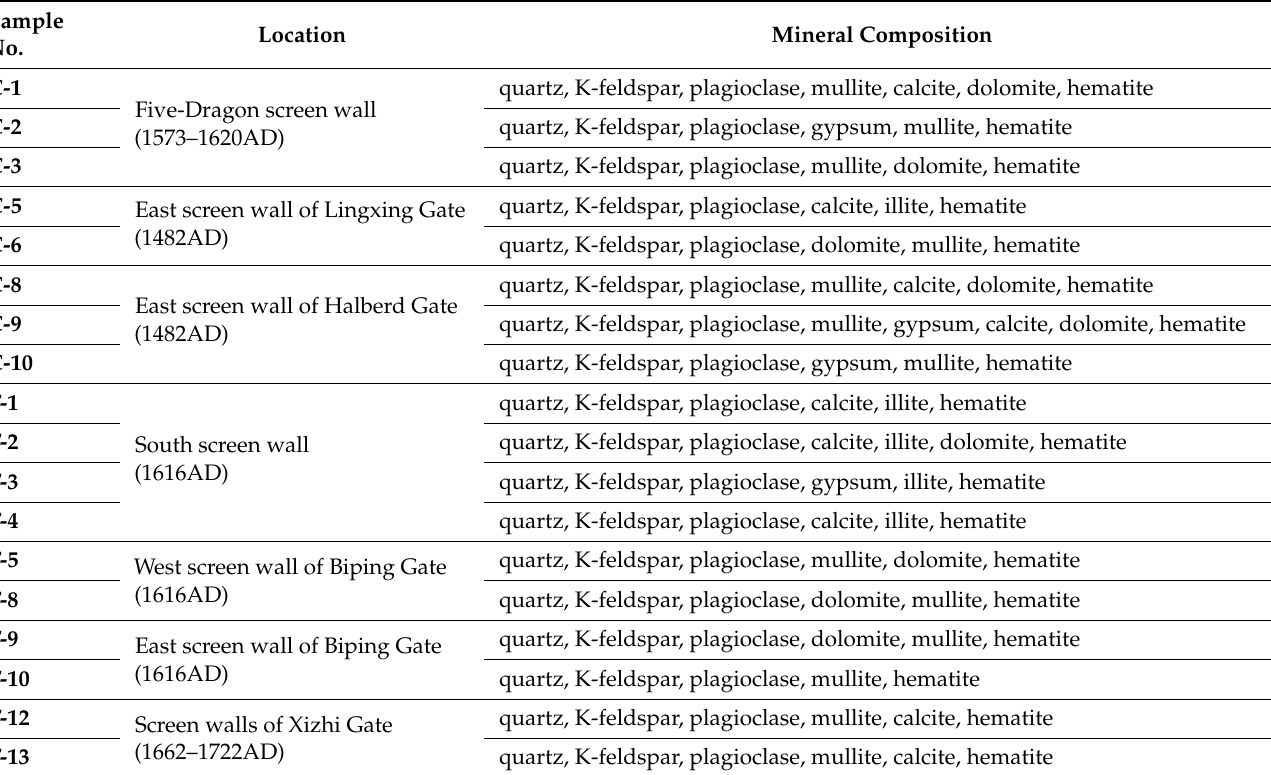
Table 3. Mineral composition of the body of Hancheng glazed tile